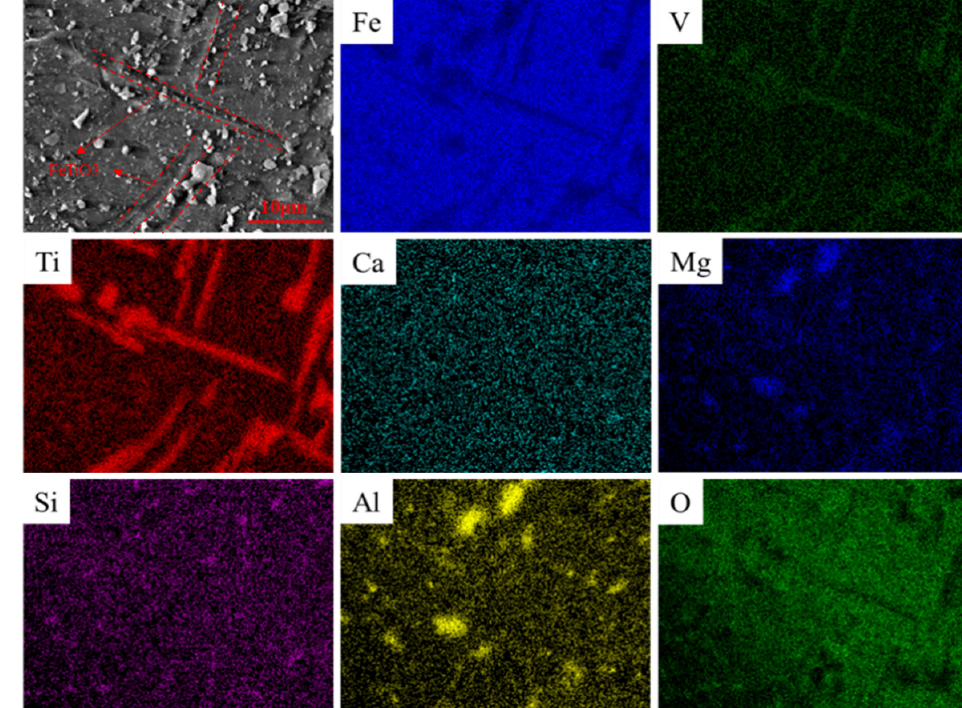
Figure 2. SEM images and element distribution maps of the VTMCs.